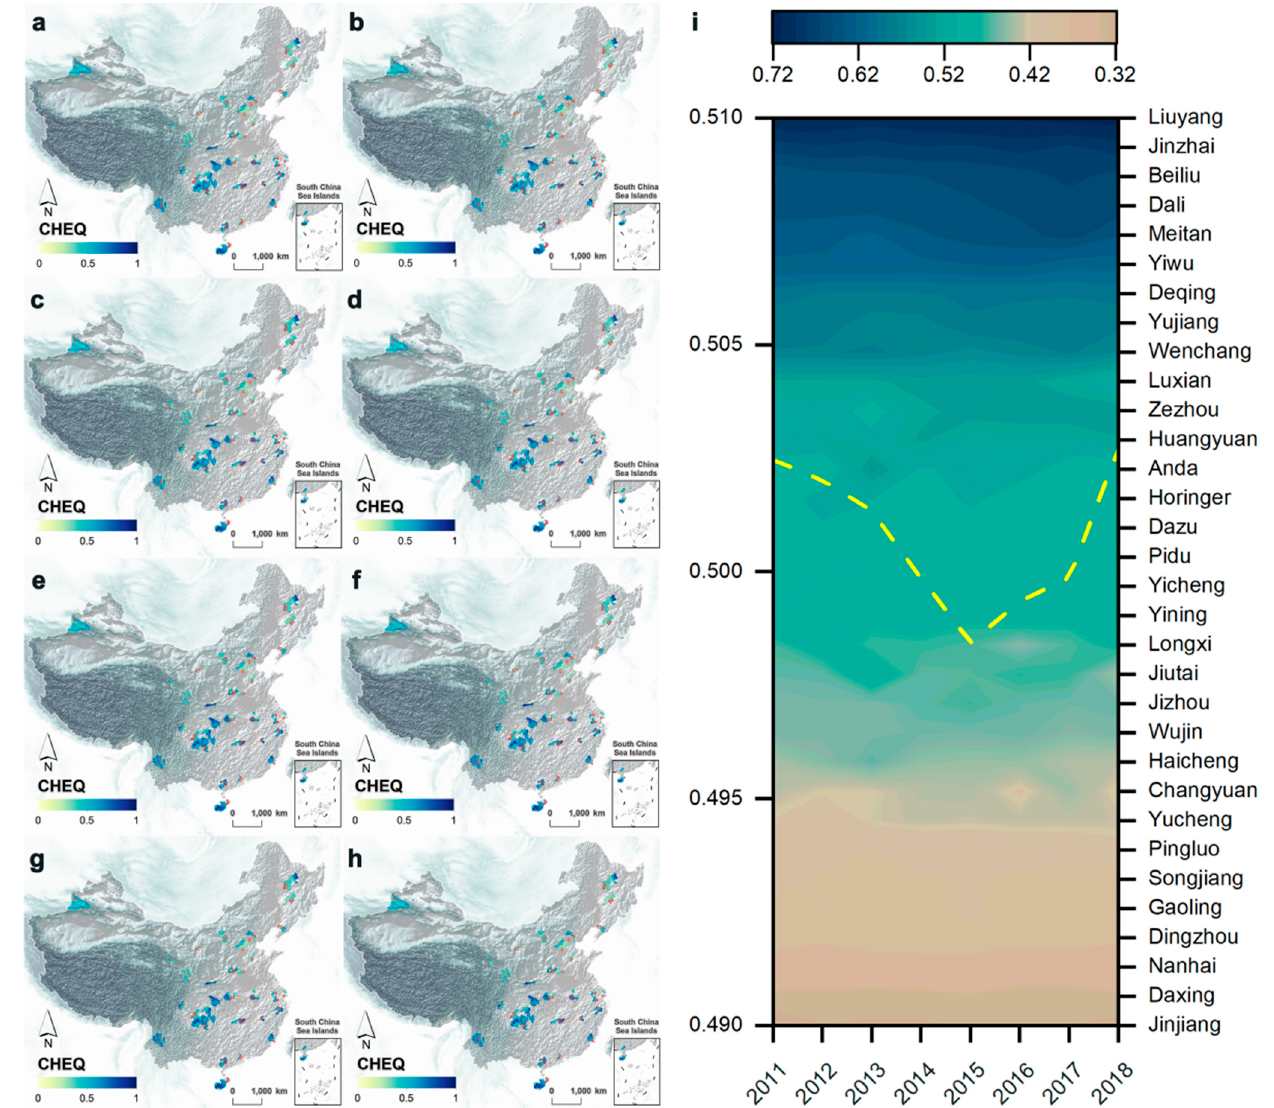
Figure 4. Spatial and temporal variation maps of EEQ in 229 counties: ( a–h ) Spatial distribution maps of EEQ in 229 counties from 2011 to 2018; ( b ) EEQ heat map of 32 pilot counties from 2011 to 2018 ( i ).